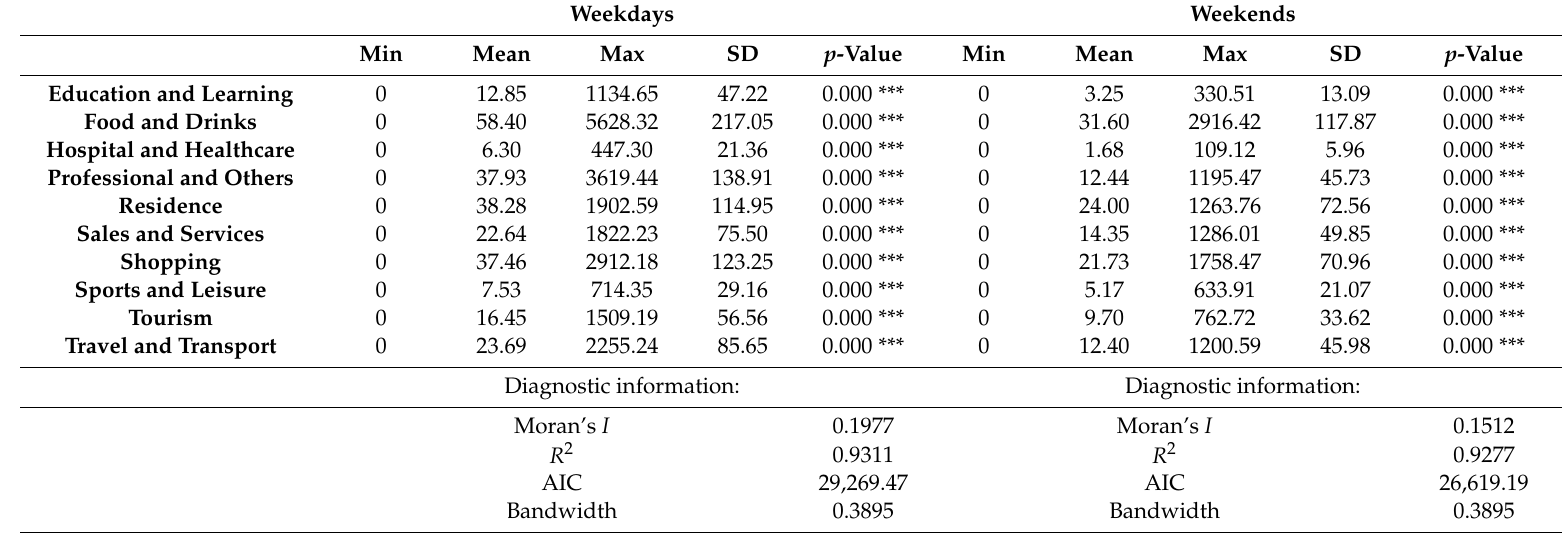
Table 5. Estimated GWR parameters of activities in Shanghai during weekdays and